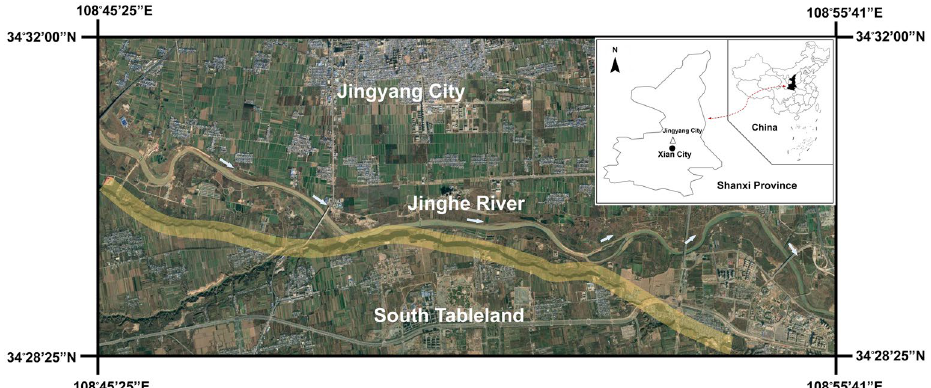
Figure 1. Location of the South Jingyang Tableland (drawing based on Google